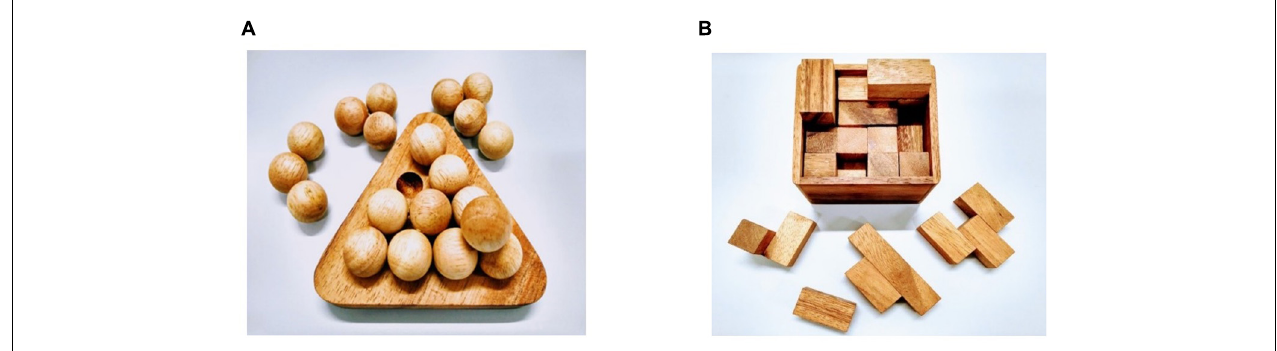
FIGURE 2 | Puzzles used for Task IV. (A) Pyramid, consisting of 6 pieces, each one composed of a differing number of spheres and spatial configuration; (B) Cube, consisting of angular pieces of different shapes. The cube volume was 6.8 cm 3 when assembled.